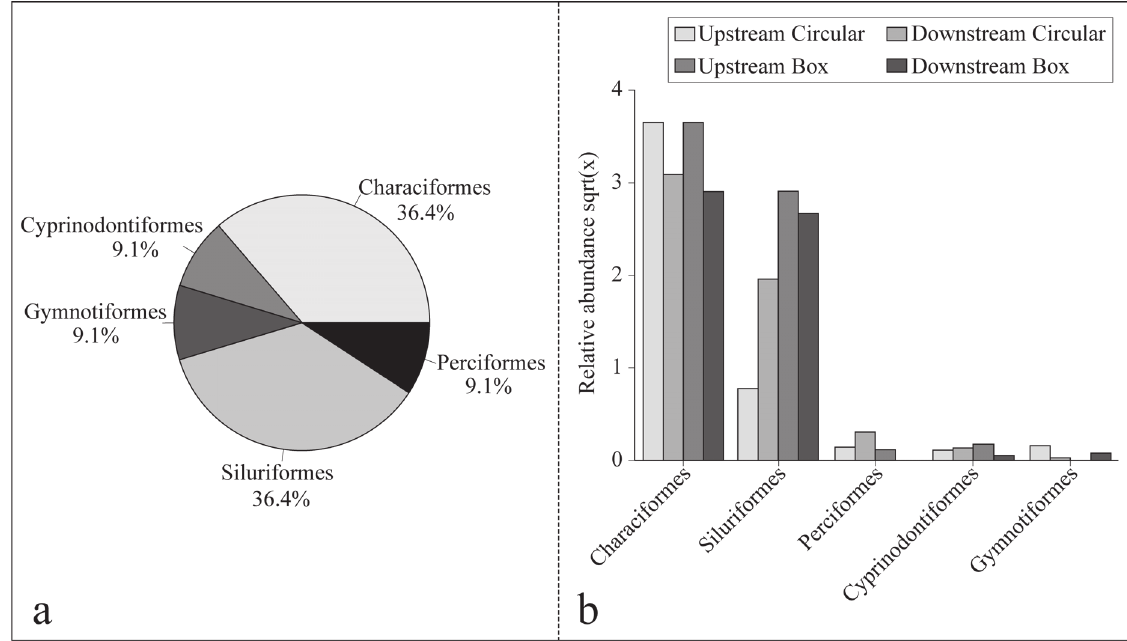
Fig. 4. Relative frequency of number of fish sampled by Order ( a ), and relative frequency of the number of fish by Order in the sampled stretches of the Lopeí stream - circular culvert and Pindorama stream - box culvert ( b ).